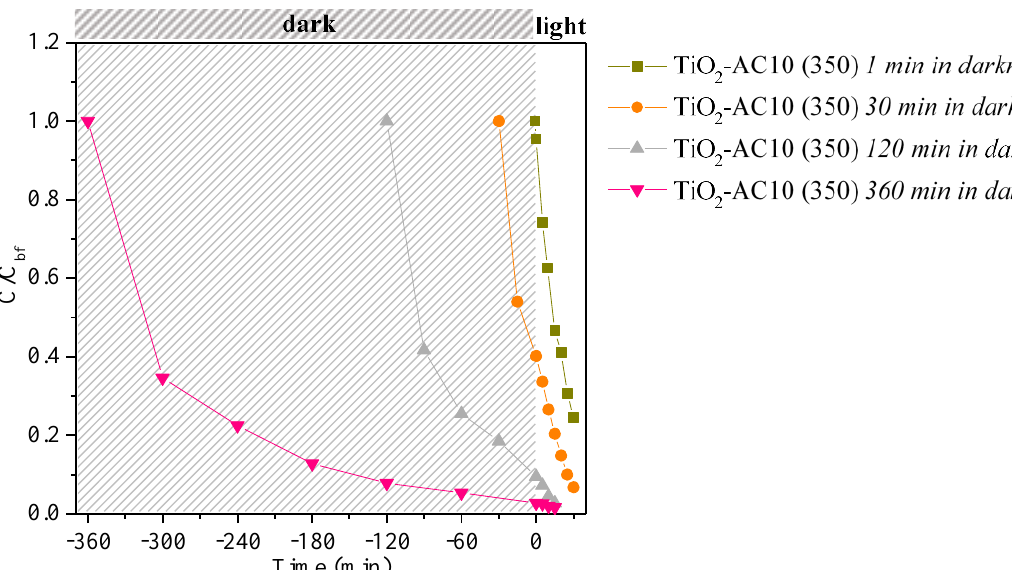
Figure 5. Evolution of the relative diuron concentration with time using TiO 2 -AC10 (350) sample in darkness (for 1, 30, 120 or 360 min) and under illumination conditions. The corresponding Ln(C 0 /C) vs. irradiation time plots for the removal of diuron under simulated solar light in the case of TiO 2 -AC10 (350) sample is reported in Figure S6, in the Supplementary Materials. Table 3. Apparent first-order rate constant ( k app ) for TiO 2 -AC10 (350) sample in experiments with different pre-adsorption time in darkness and the corresponding linear regression coefficient R 2 . Sample Time in Darkness